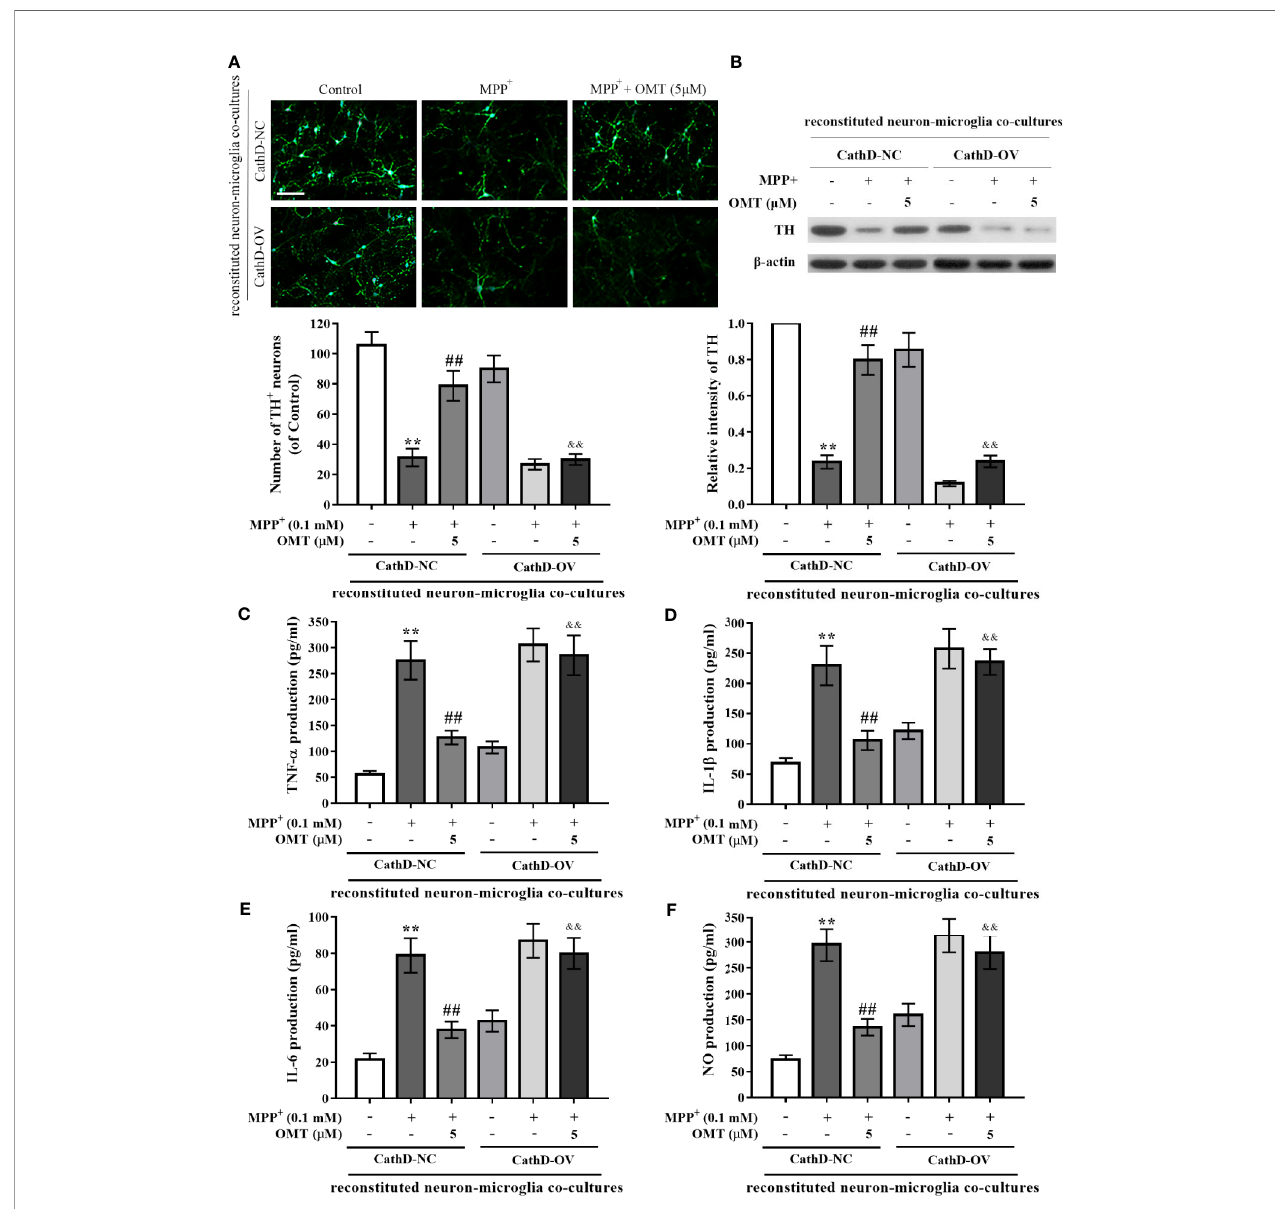
FIGURE 6 | Overexpression of CathD reversed OMT-produced neuroprotection in reconstituted neuron-microglia co-cultures. Mice primary microglia after overexpression of CathD was transferred to neuron-enriched cultures. After that the reconstituted neuron-microglia co-cultures were pretreated with MMP + for 6 h, followed by treatment with 5 m M OMT for 24 h. (A) DA neurons quanti fi cation was determined by TH-immuno fl uorescence staining. Scale bar: 100 m m. (B) The expression of TH in reconstituted neuron-microglia co-cultures was determined by Western blot analysis. (C – F) Levels of pro-in fl ammatory cytokines, such as TNF- a (C) , IL-1 b (D) , IL-6 (E) , and NO (F) in reconstituted neuron-microglia co-cultures were tested by ELISA (C-E) and Griess (F) analysis. The data are presented as mean ± SEM. **p < 0.01 vs. CathD-NC reconstituted co-cultures; ## p < 0.01 vs. MPP + -treated CathD-NC reconstituted co-cultures; && p < 0.01 vs. MPP + - and OMT-treated CathD-NC reconstituted co-cultures. Student ’ s t